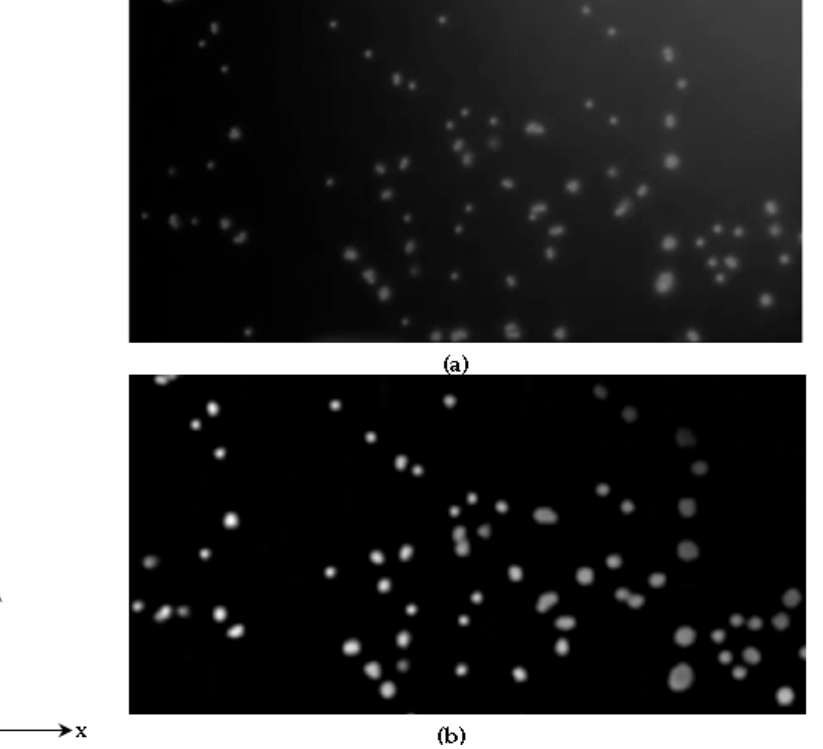
Figure 17. Particle image processing results in PIVlab for 4 µm diameter particles: ( a ) raw image and ( b ) PIVLAB pre-processed image with filters prior to cross-correlation analysis.